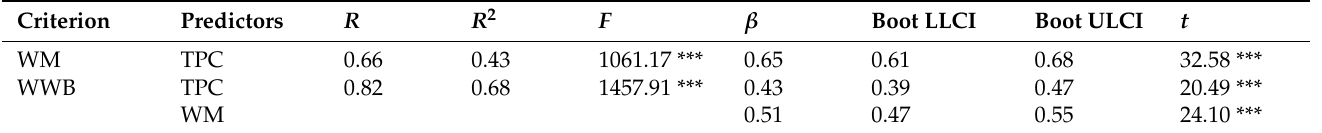
Table 3. Testing work-meaning cognition as a mediator in the relationship between workplace well-being and teachers’ psychological capital (N = 1388).